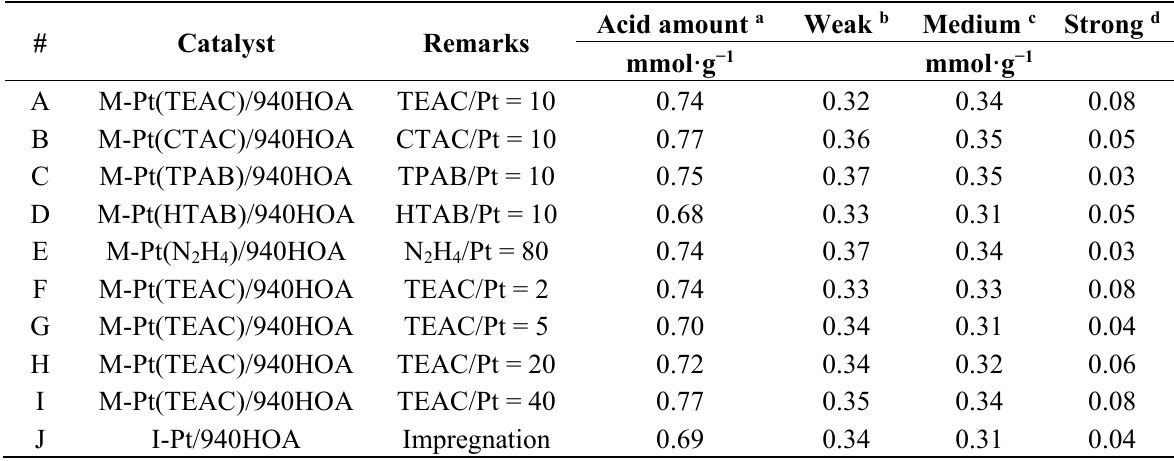
Table 3. NH 3 -TPD results of Pt-loaded zeolite